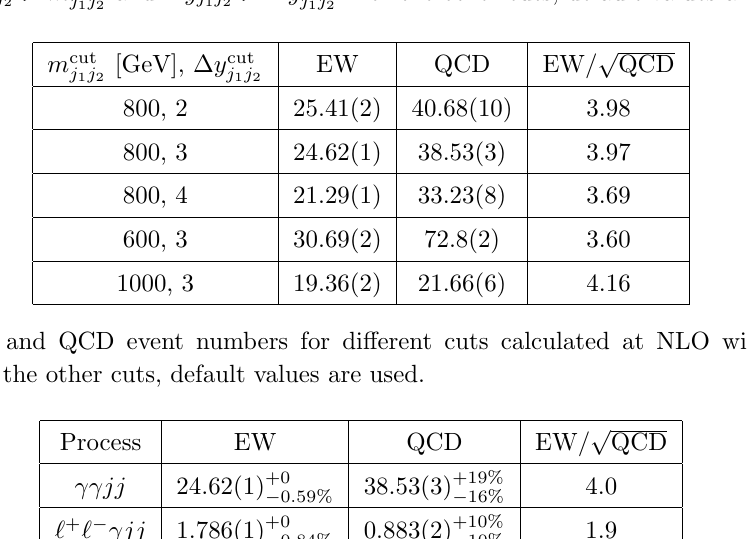
Figure 4 . Dependence of the NLO signi(cid:12)cance EW = p QCD calculated with luminosity L = 1 fb (cid:0) 1 on the cuts m j > m cut and (cid:1) y j > (cid:1) y cut . For the other cuts, default values are used. j 1 j 2 j 1 j 2 1 j 2 1 j 2